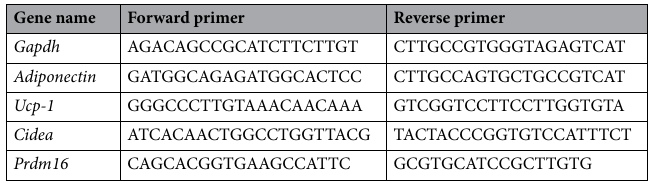
Table 1. Gene primer